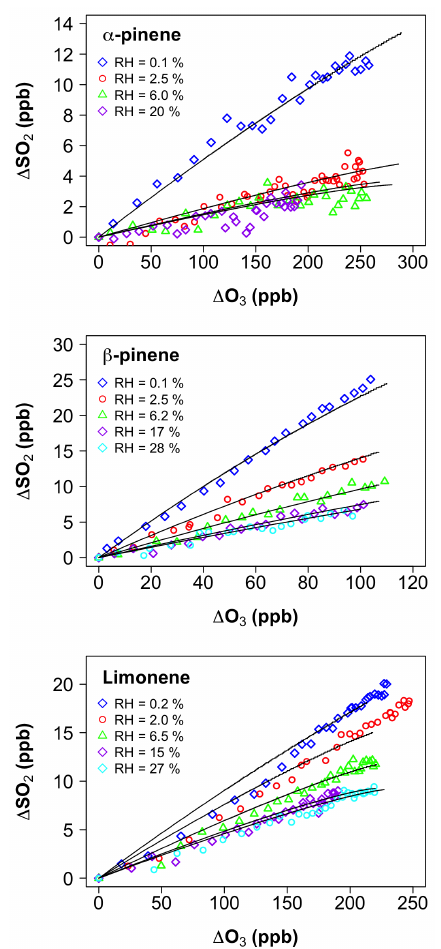
Figure 2. Cumulative consumption of SO 2 as a function of cumula- tive consumption of O 3 and (cid:49) SO 2 versus (cid:49) O 3 for the ozonolysis of α -pinene, β -pinene and limonene in the presence of SO 2 at a range of water vapour concentrations, from 1 × 10 15 to 1.9 × 10 17 cm − 3 . Symbols are experimental data, corrected for chamber dilution. Lines are smoothed fits to the experimental